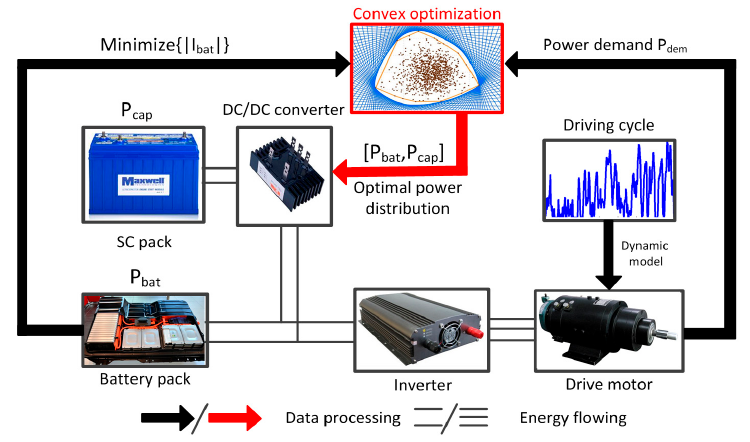
Figure 8. The implementation process of the convex optimization strategy.